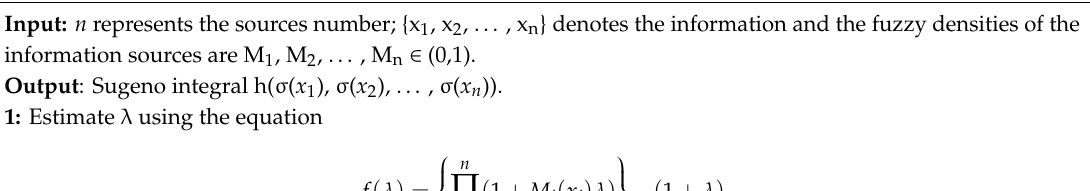
Algorithm 1: Sugeno integral